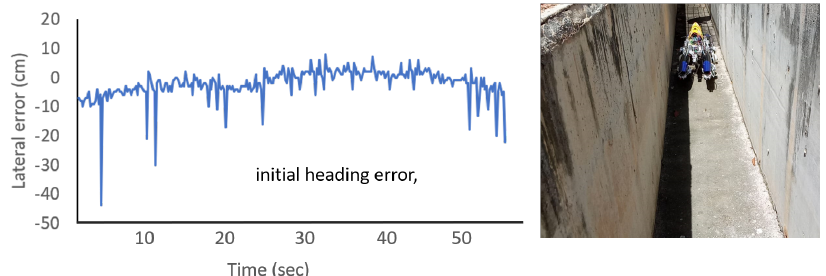
Figure 21. The collision avoidance results in a real